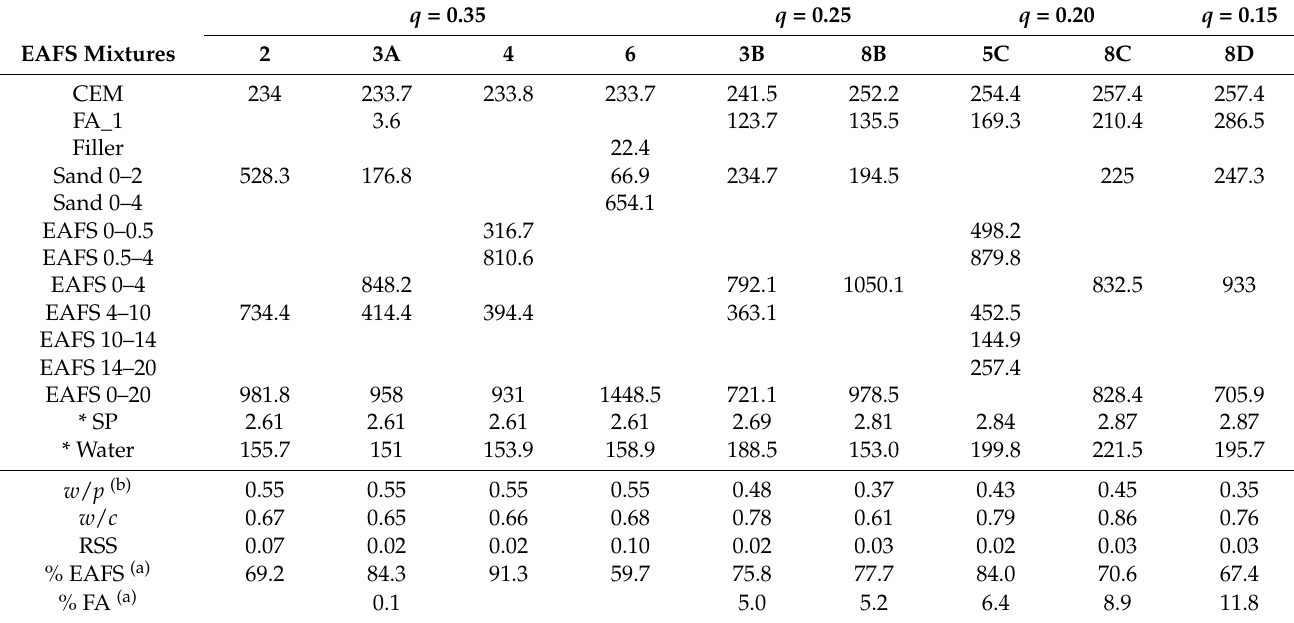
Table 5. Designed EAFS mixtures based on REF1 [kg/m 3 or * L/m 3 ].